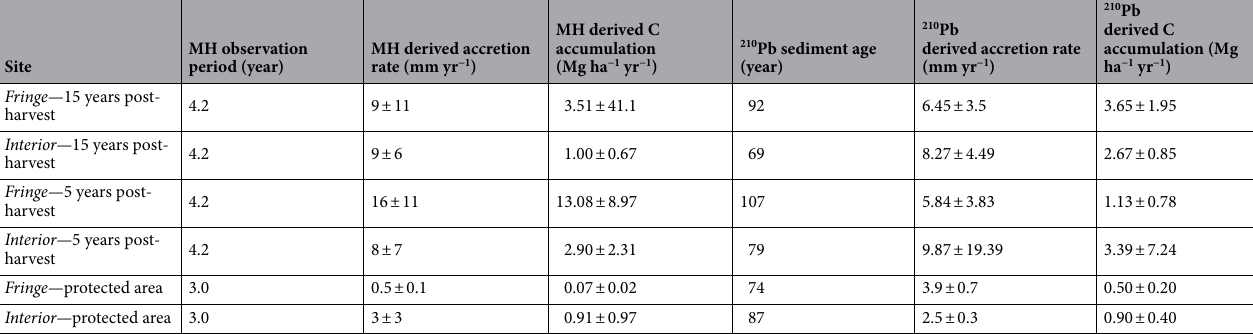
Table 1. Comparison of contemporary (MH derived) and historical ( 210 Pb derived) accretion rates and carbon accumulation rates in 5-year-old, 15-year-old and protected stands, in fringe and interior hydro-geomorphic settings. Accretion and carbon accumulation rates are presented as mean ± SD. MH marker